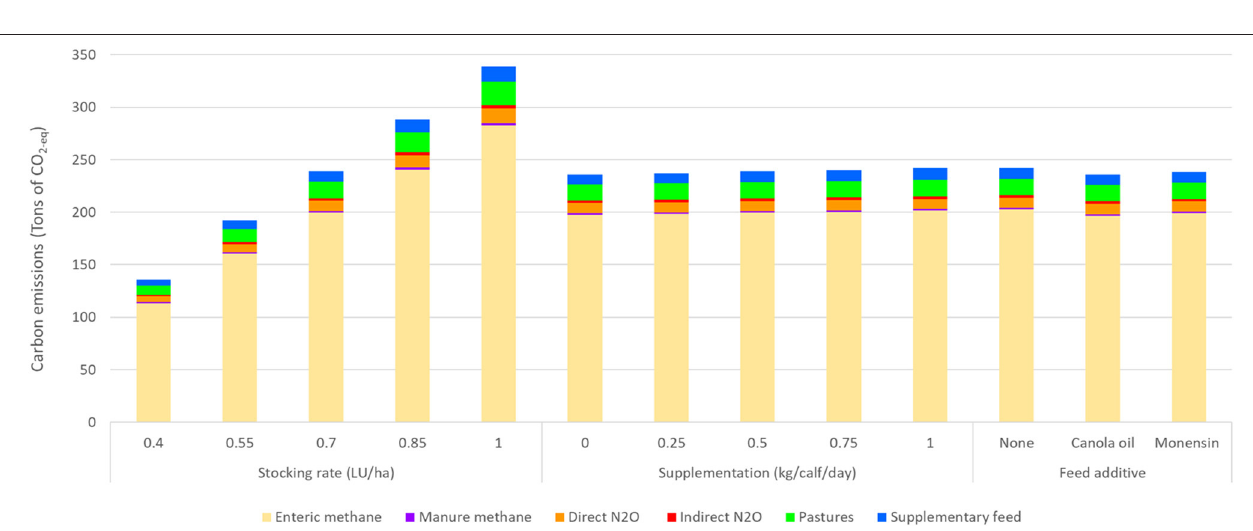
FIGURE 4 | Effect of calf supplementation, additive stocking rate, and carbon sequestration on the carbon footprint (CF) of the simulated scenarios.